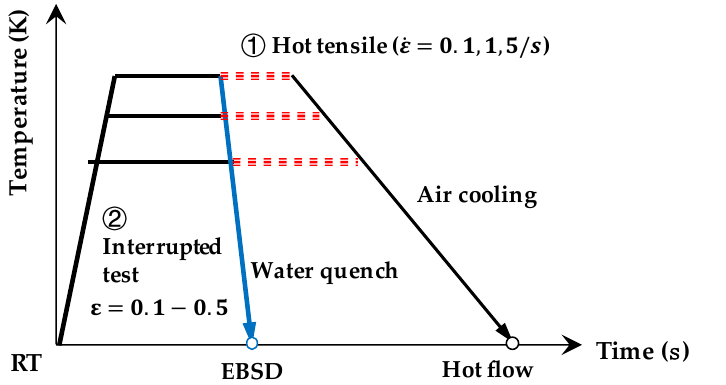
Figure 3. Test procedures of ① hot tensile test until failure and ② interrupted test under differ- enttest conditions.